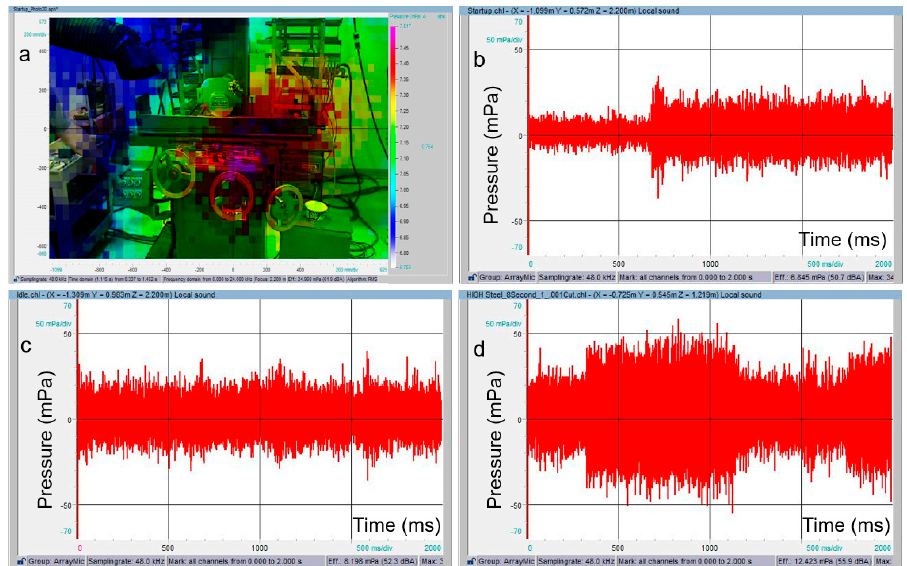
Figure 4. Acoustic emission for surface grinder: ( a ) 2D image superimposed with noise mapping intensity; ( b ) noise emission during startup; ( c ) noise emission during idle speed; and ( d ) noise emission during load.